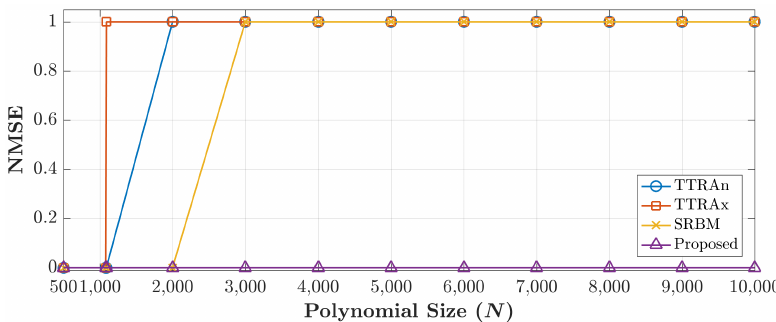
Figure 7. Reconstruction error of the proposed and existing